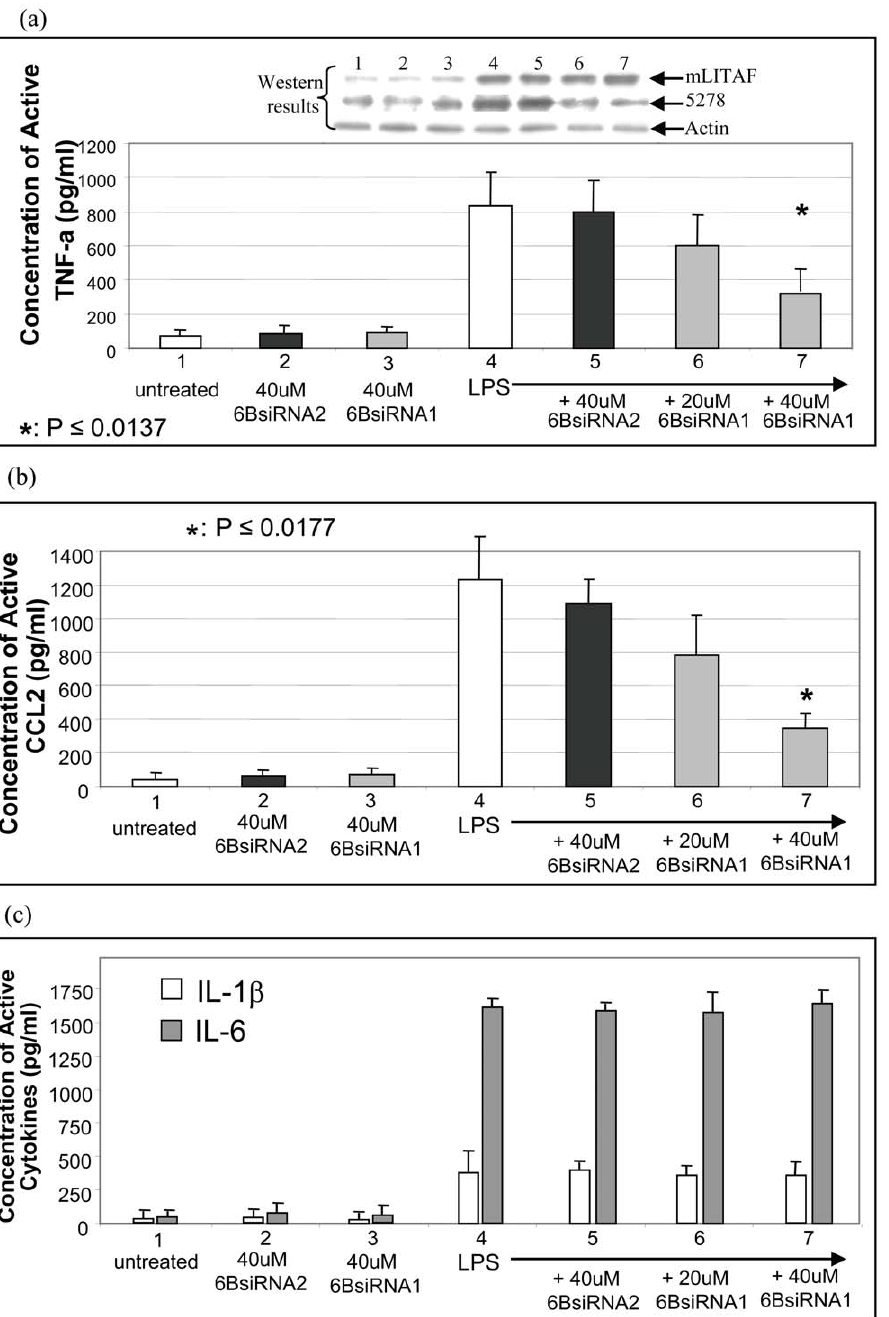
Figure 5. Effect of 6BsiRNA1 on LPS-induced serum TNF- a or CCL2 production. Mice (n=6 6 6 groups) were treated as shown in Table 1. Total of 100 ul PBS solution containing 1 mg E. coli LPS plus 40 nM 6BsiRNA2 as control, or plus 20 nM 6BsiRNA1 or 40 nM 6BsiRNA1 was injected into each mouse. Blood was collected 5 hrs after injection. Mice were warmed under heating lamps to promote blood flow, and a small incision was made on the tail. About 50 m l of blood was collected per mouse. Red blood cells were removed from the sample via centrifugation at 5,000 rpm for 1 min using serum separator tubes. Top Panel: protein expression from each sample (Nos 1-7) detected by Western blot using antibodies against mLITAF, 5278 or Actin (control). Lower panel: serum levels of TNF- a (a), CCL2 (b) or IL-1 b , IL-6 (c) from each sample measured by ELISA. ELISA immunoreactivity was quantified using a microplate reader and measurements were graphed. The assays were performed in triplicate and a representative experiment is presented.